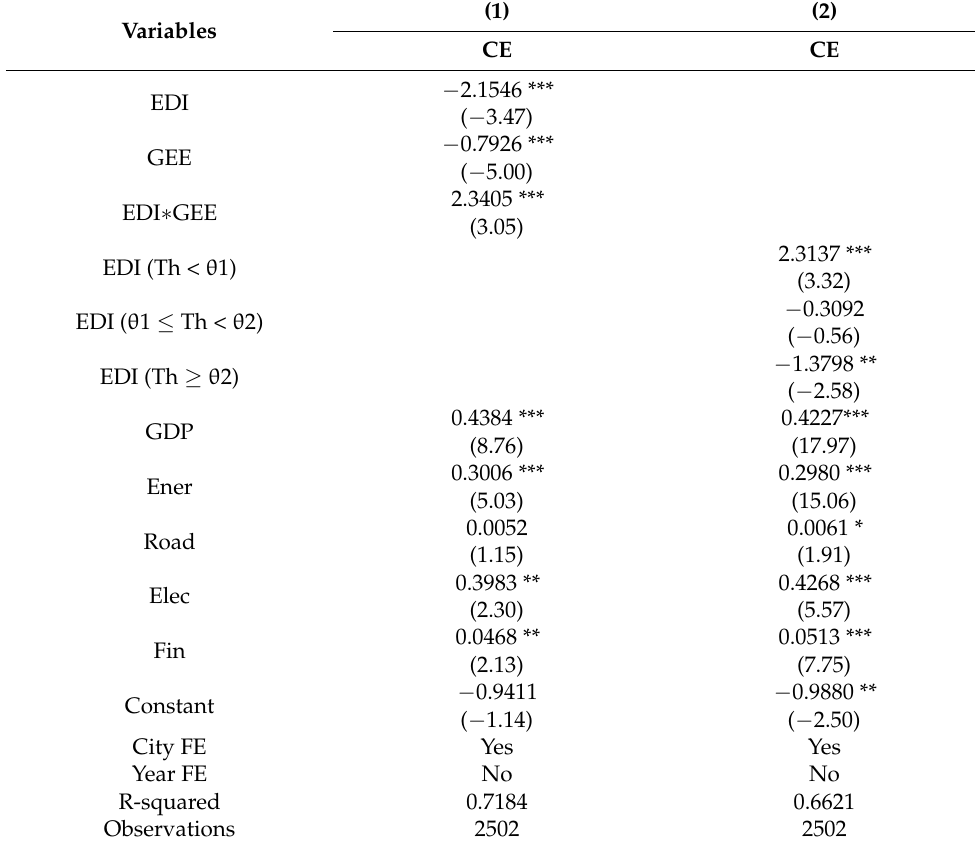
Table 6. Regression results of interaction effect model and threshold model.